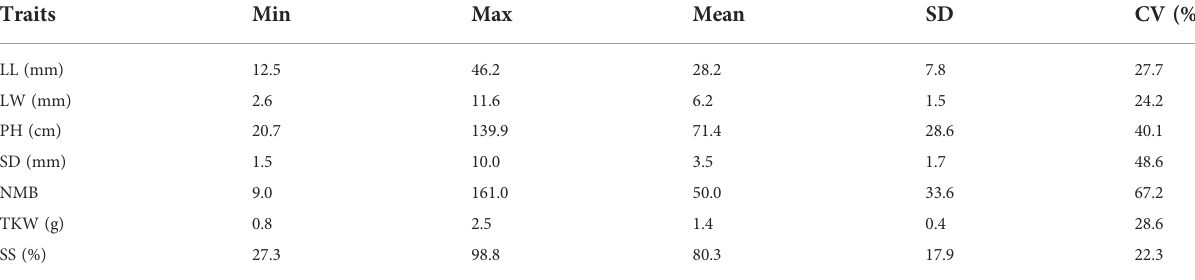
TABLE 2 Morphological variations in the seven seed shattering-related traits among the 68 stylo accessions.